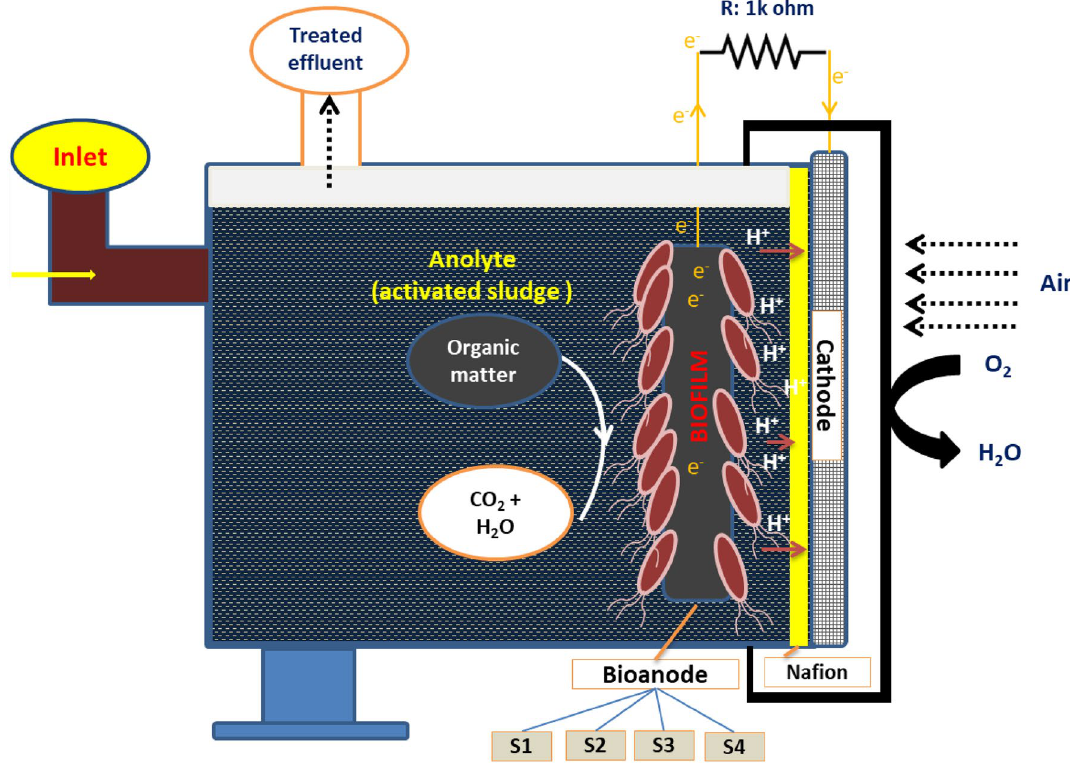
Figure 1. Configuration of the fabricated MFC system with a chamber. The rectangular-shaped chamber was made of polyacrylic plastic with a total liquid volume of 50 mL. The dimension (length × width × height) of the anodic chamber was 80 × 80 × 30